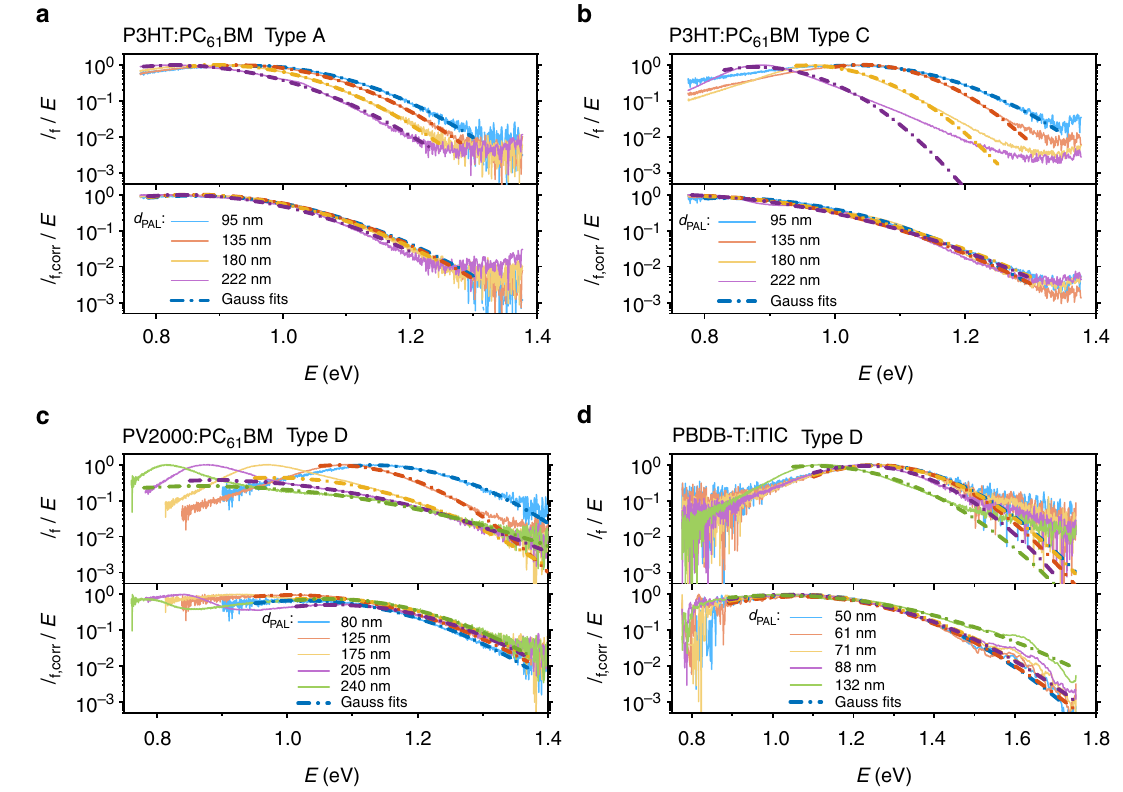
Fig. 6 Reduced emission spectra I f / E and corrected spectra I f,corr / E data (solid lines). Gaussian fi ts (dashed lines) given by Eq. (1) for P3HT:PC 61 BM devices of type A in a and P3HT:PC 61 BM devices of type C in b as well as type D devices made from PV2000:PC 61 BM ( c ) and PBDB-T:ITIC ( d )